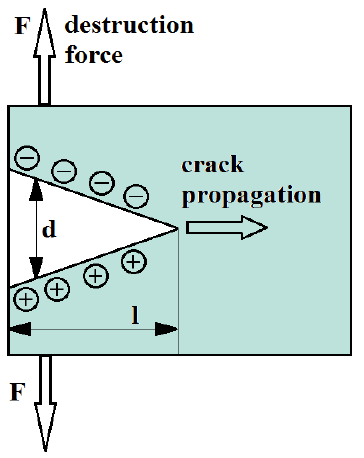
Figure 1. The formation of a crack in the rock structure.